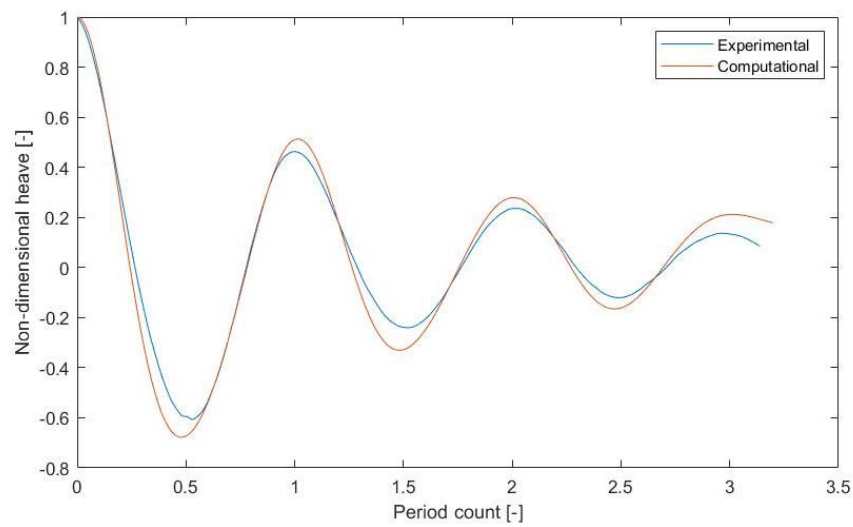
Figure 9. Signal comparison of the experimental (blue) and computational (orange) decays with the interaction of mooring systems.